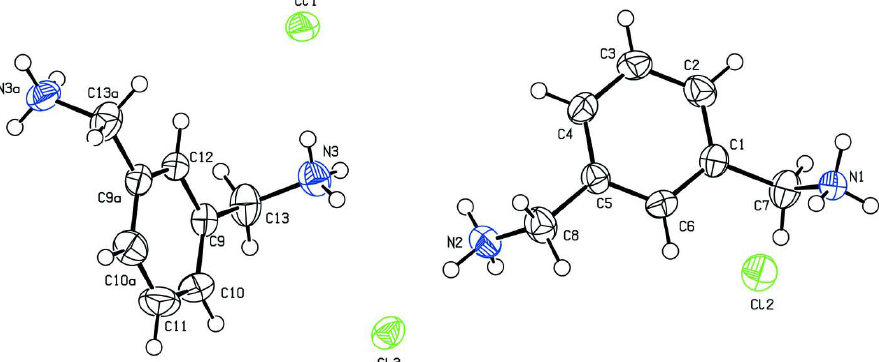
View of (I) showing the atom-labelling scheme. Displacement ellipsoids are drawn at the 30% probability level. H atoms are represented by spheres of arbitrary